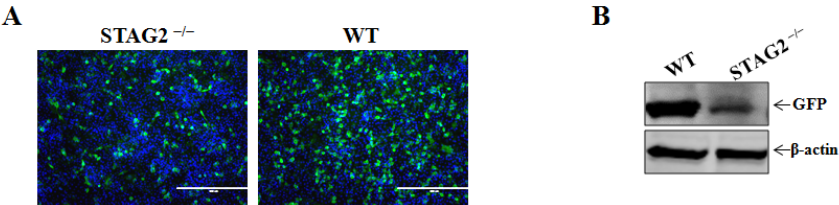
Figure 2. Confirmation of STAG2 as a critical host factor for VSV infection. ( A ) WT and STAG2 − / − were infected with VSV (MOI = 0.1). The VSV-GFP was visualized at 10 h post infection with an Olympus inverted fluorescence microscope equipped with a camera; ( B ) WT and STAG2 − / − were infected with VSV (MOI = 0.1). Cell samples were harvested and subjected to immunoblotting with antibodies as indicated.